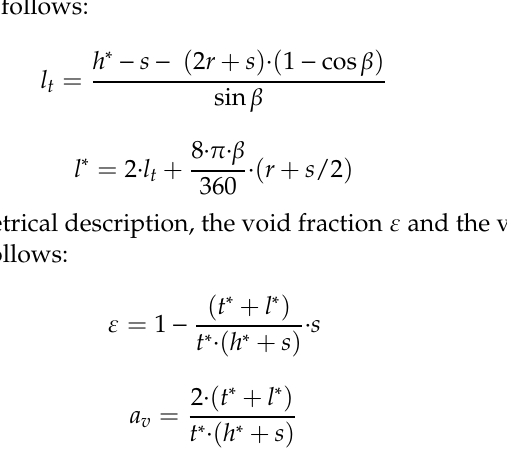
∗ , which is within